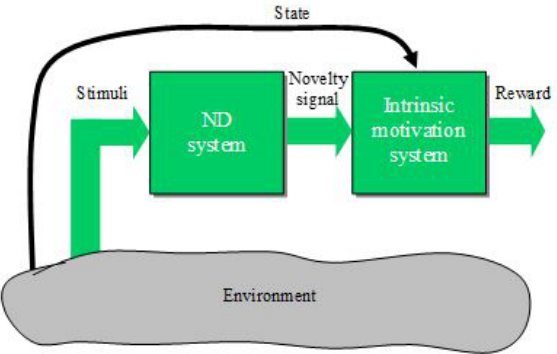
Figure 4: Functional dependency of ND and